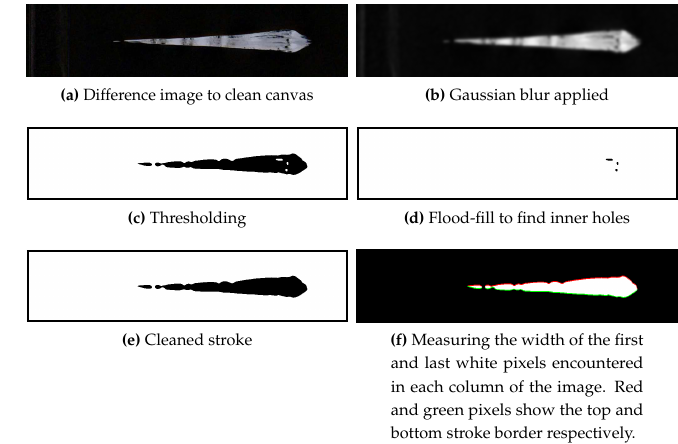
Figure 6. Pressure/Width calibration of a brush.